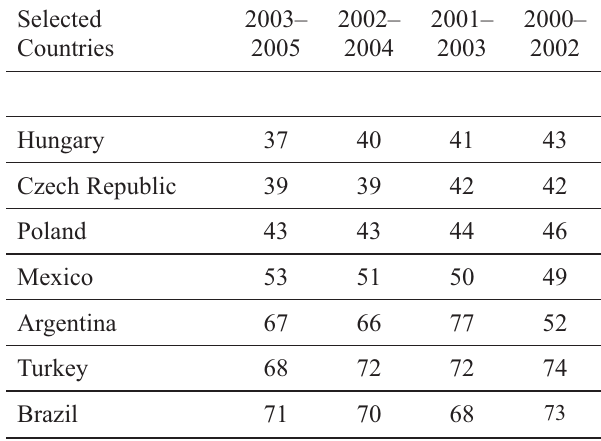
Table 2 . The Inward FDI Potential Index Rankings Selected